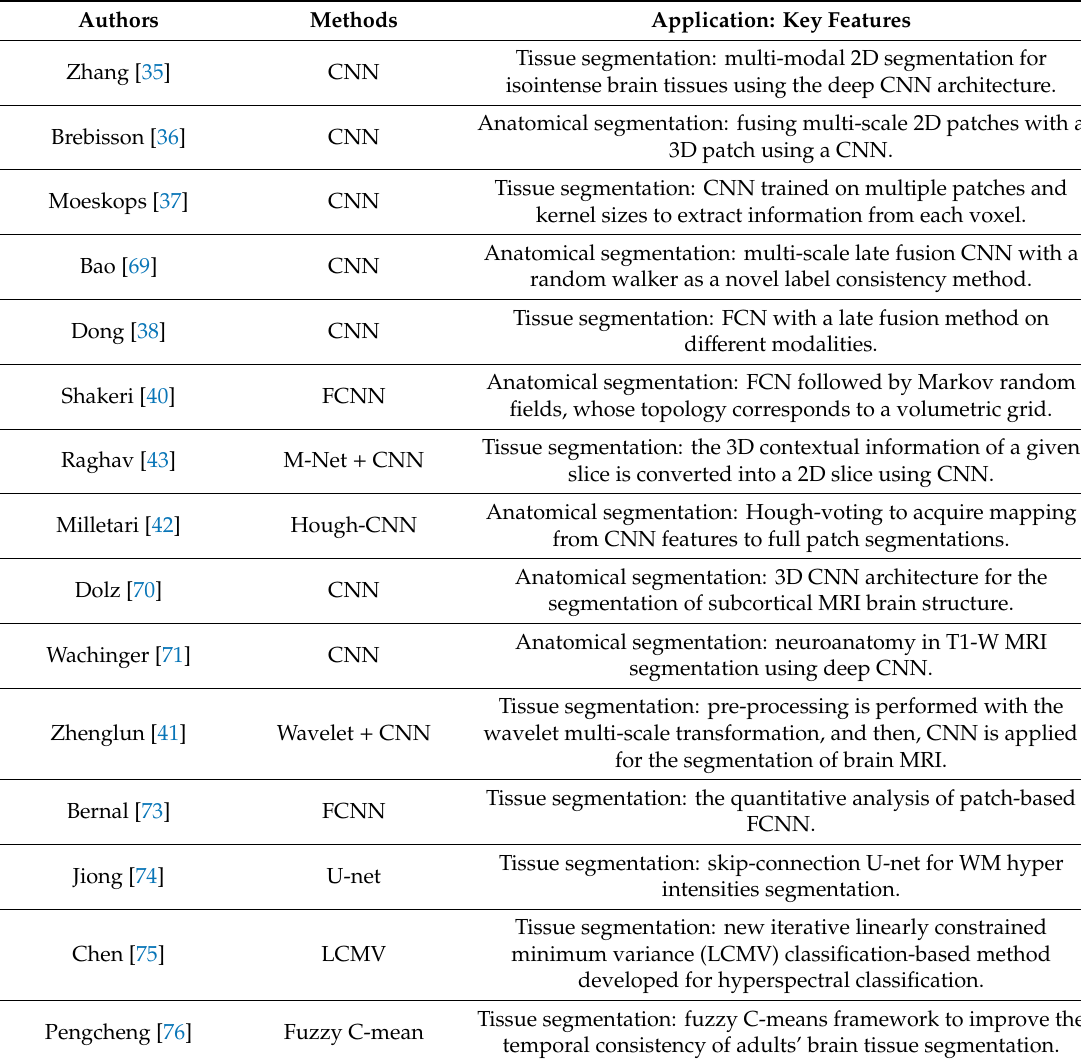
Table 4. Overview of papers using deep learning techniques for the segmentation of brain